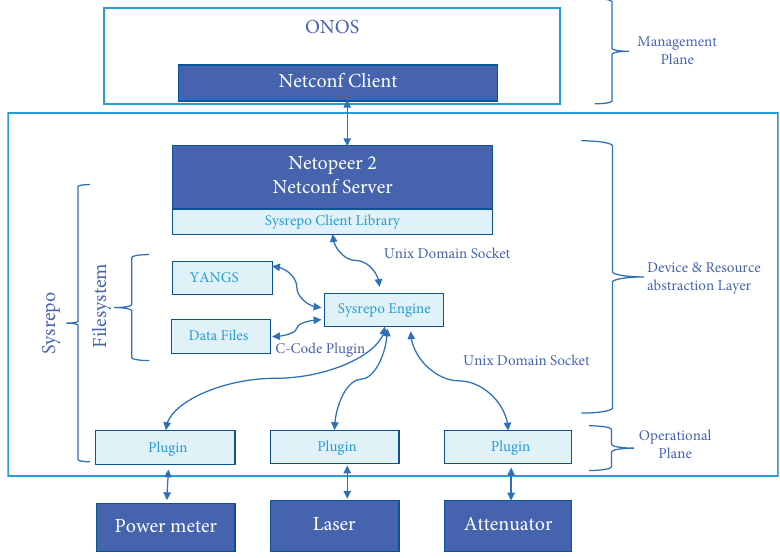
Figure 14: SDN architecture for legacy